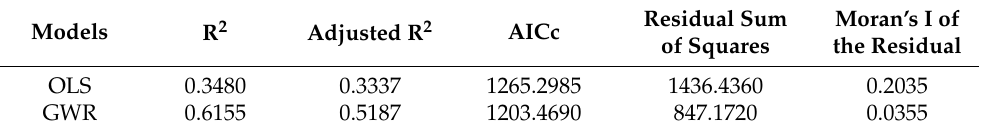
Table 5. Comparison of coefficients between the OLS model and the GWR model.